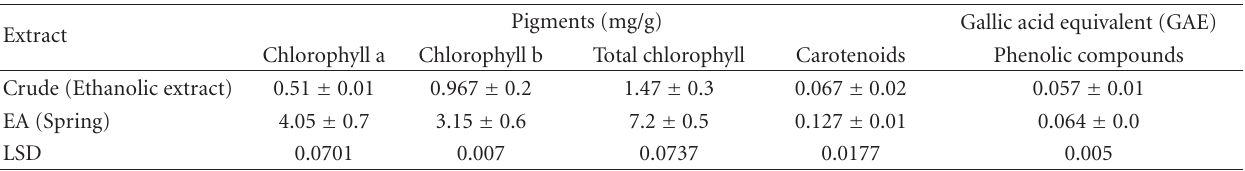
Table 6: Pigments (chl a, b, total chlorophylls, and carotenoids) and phenolic compounds (of spring collected E. compressa ) in ethyl acetate (EA) extracts expressed as mg/g and GAE.